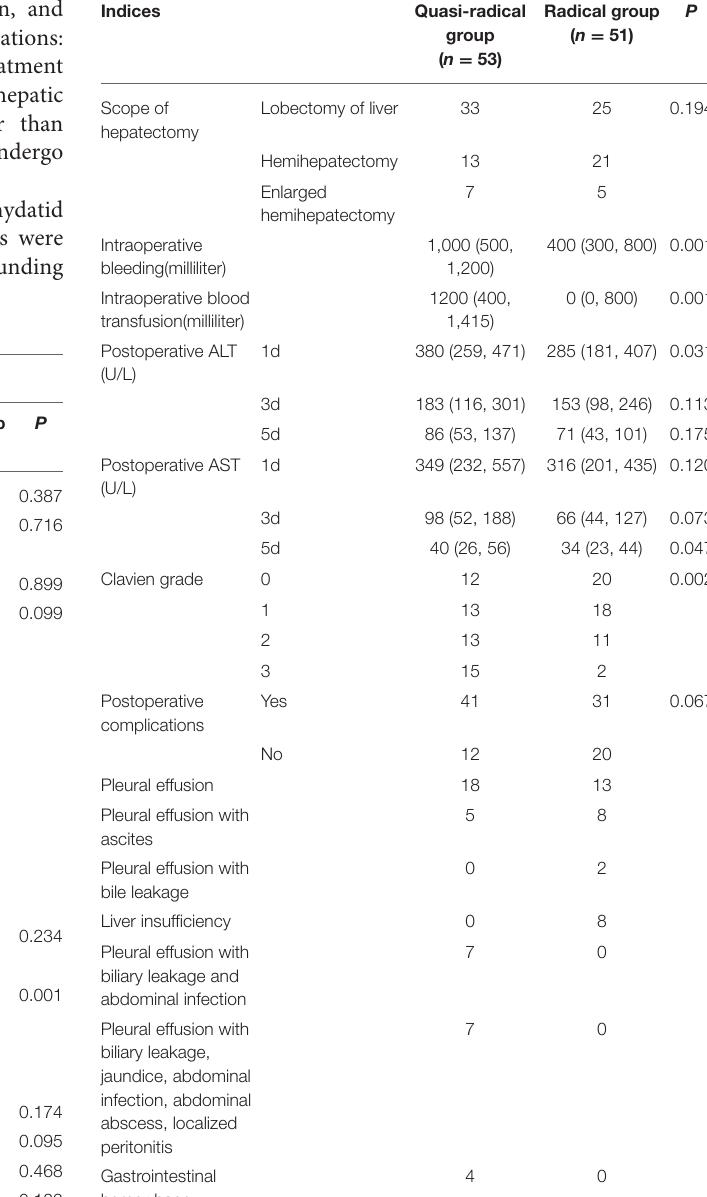
TABLE 2 | Comparison of intraoperative conditions and postoperative recovery between the two